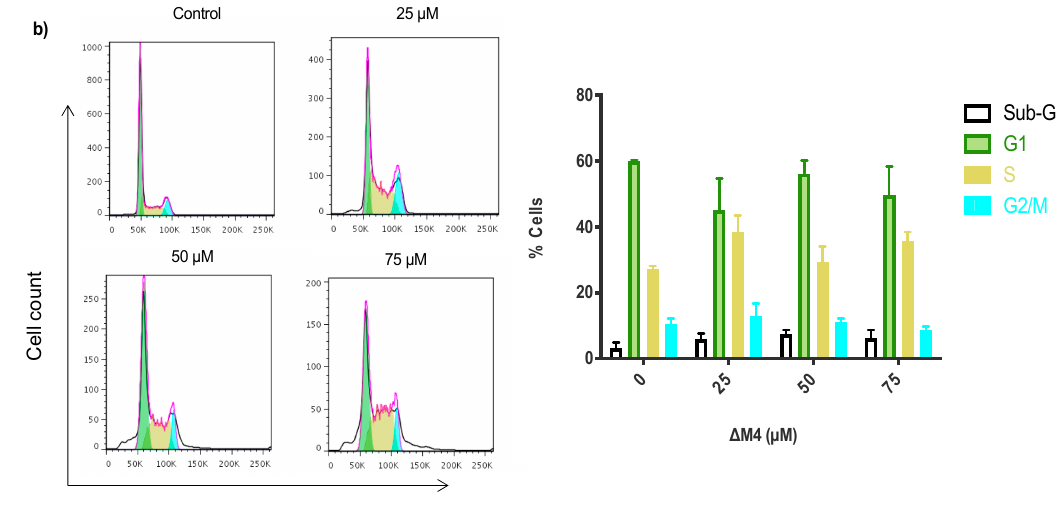
Figure 5. Cell cycle distribution after ∆ M4 exposure in melanoma skin cancer and non-tumoral cells. Cells were treated with di ff erent concentrations of ∆ M4 for 24 h. ( a ) A375, melanoma cancer cells; ( b ) HaCaT, normal human keratinocyte cell line. The following are shown for each cell line: A representative histogram of flow cytometry analysis of the cell cycle distribution; bar graphs for quantification of the cell cycle distribution of the total cell population in the different phases of the cell cycle; and two-way ANOVA for sub-G1, G1, S, and G2/M populations, displaying the difference with respect to untreated cells, where ** p ≤ 0.01.